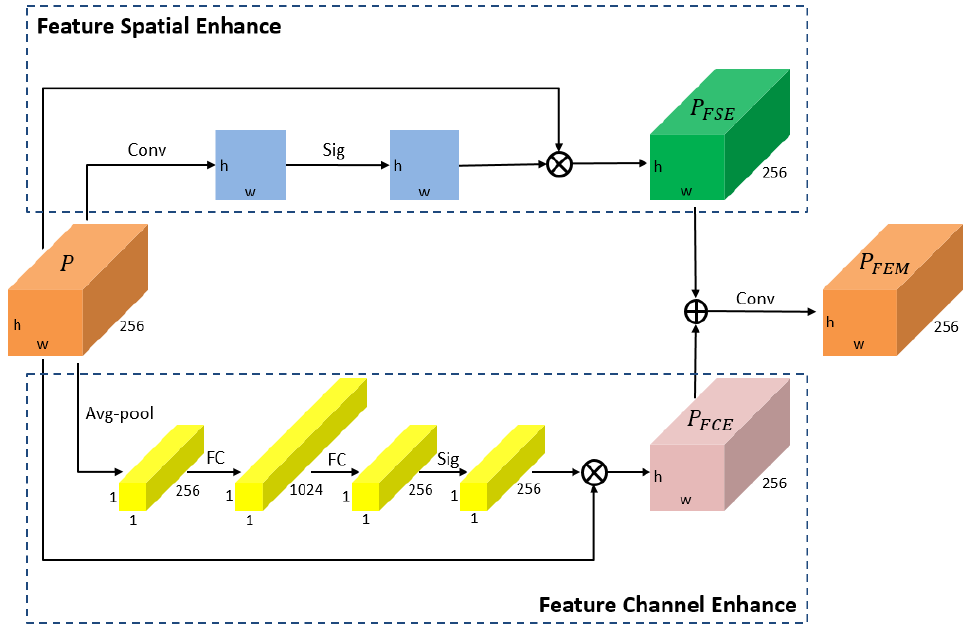
Figure 3. Details of the feature enhance module. Feature spatial enhance (FSE) fuses multi-channel information using a 1 × 1 convolution kernel and normalizes it using a sigmoid function to obtain two-dimensional spatial weights. Feature channel enhance (FCE) obtains a 1 × 256 vector using global average pooling. The vector is then calculated by two fully connected layers and normalized using the sigmoid function to obtain the one-dimensional channel weights. Enhanced features from the two approaches are superimposed together, followed by further fusion of local feature information using 3 × 3 convolution.